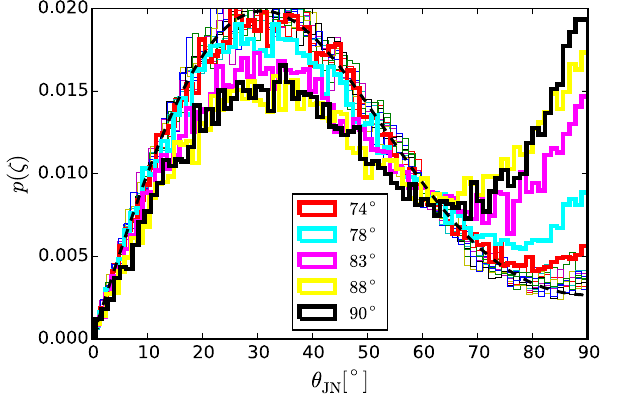
FIG. 10. The same as Fig. 2, but for source D